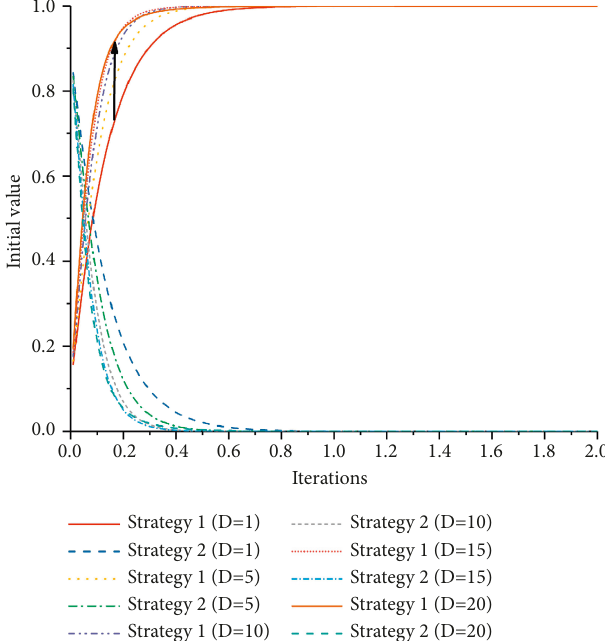
Figure 9: dx / dt − t in sensitivity analysis of D